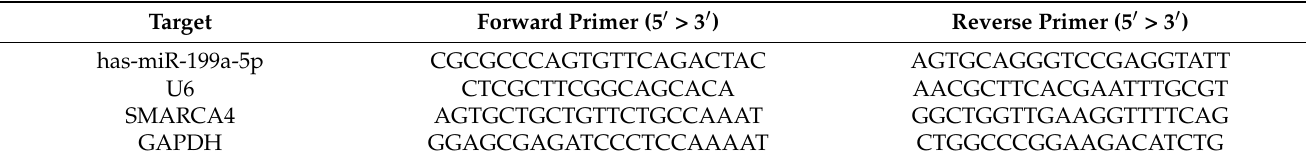
Table 2. Sequences of oligonucleotide primers used in qRT-PCR.